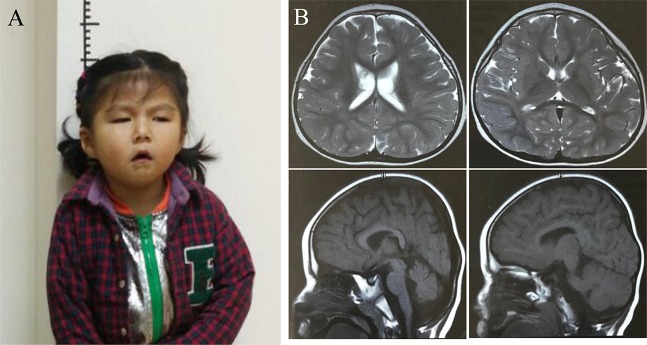
Clinical and imaging features of the proband (A) The picture illustrates the facial dysmorphic features consisting of microcephaly, micrognathia, deep-set eyes, large ears, pointed nasal tip, and a downturned mouth. Written informed consent for publication of medical data and identifiable images was obtained from the parents of the patient. (B). Brain MR images showed mild prominence of lateral ventricles, enlarged pericerebral spaces, high palate, delayed myelination, and a thin corpus callosum when the girl was at 4 years of life.